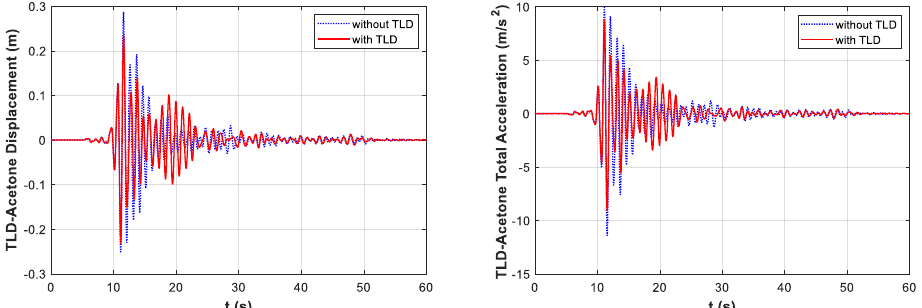
Figure 4. AHS optimization of the single-story structure displacement – time and total acceleration – time graphs in the DUZCE/BOL090 earthquake record for TLD – acetone.